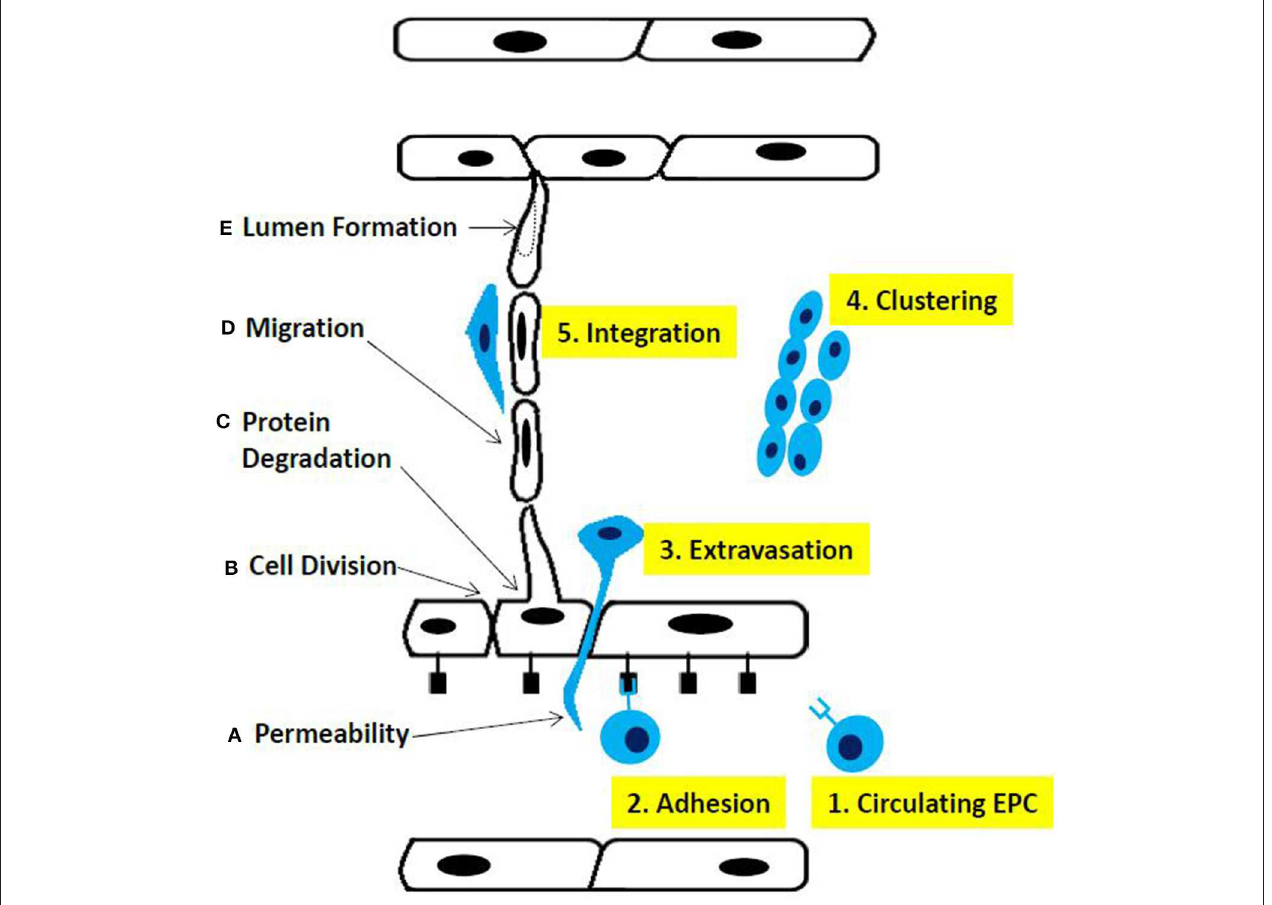
FIGURE 2 | Phases of sprouting angiogenesis. (A) increased permeability across the endothelial cell layer, (B) cell division, (C) proteolysis of basement membrane components, (D) migration ofthe endothelial cells, and (E) lumen fonnation. Altematively, (1) circulating endothelial progenitor cells contribute to the sprouting mechanism, (2) adhere to endothelial cells, (3) extravagate through the endothelial cell layer, (4) cluster together, and (5) integrate into the sprout fonned by endothelial